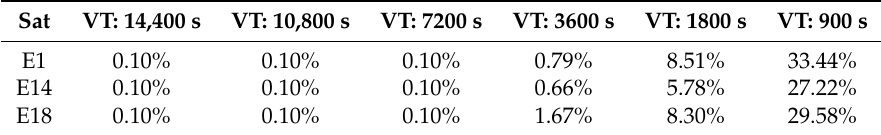
Table 6. Percentage of discarded epochs, DOYs